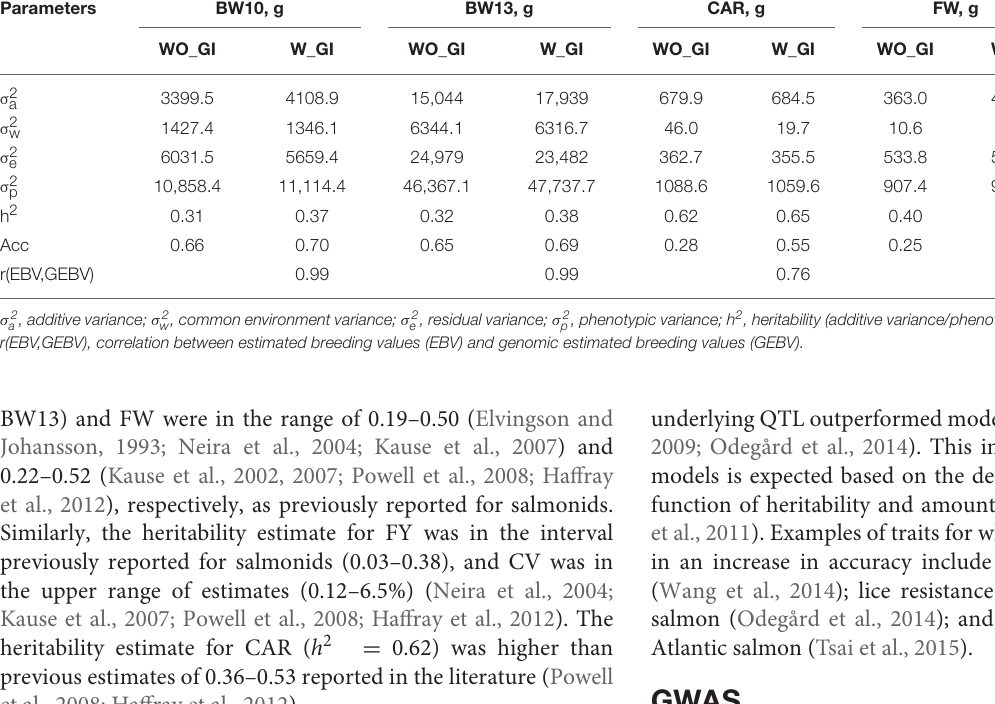
Table S2 . Only 13 of the 40 SNPs identified by the